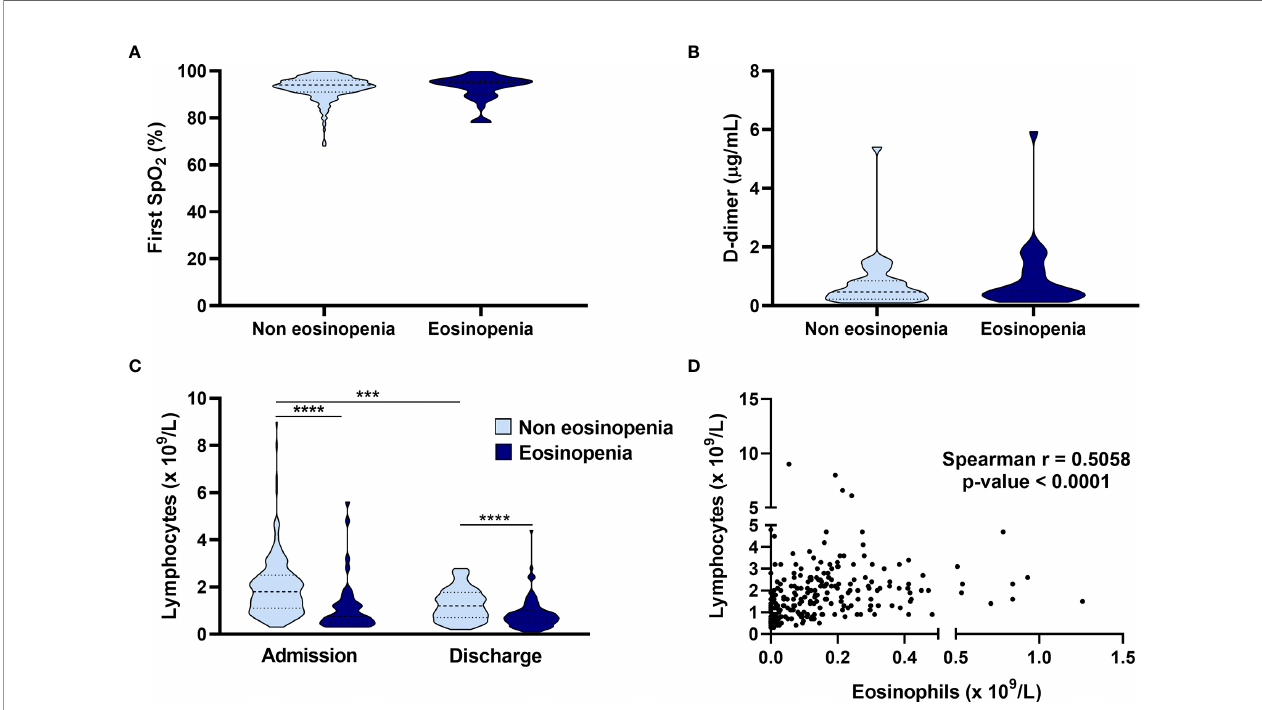
FIGURE 4 | Relationship of eosinopenia with clinical and laboratory parameters. Comparison of the eosinopenia group and non-eosinopenia group regarding peripheral capillary oxygenation saturation on admission (A) , with no differences between groups; D-dimer on admission showed similar results (B) ; the absolute lymphocyte count on admission was higher in the non-eosinopenia group, and both groups presented higher absolute lymphocyte counts on admission than at discharge (C) ; suggesting a correlation between lymphocytes and eosinophils (D) . ***p < 0.001; **** p <